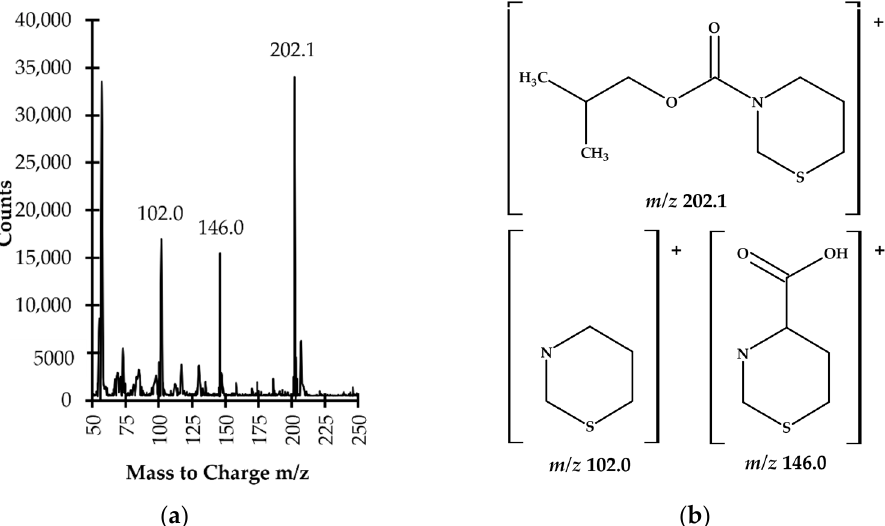
Figure 6. ( a ) Electron ionization (EI) mass spectrum of 1,3-thiazinane-4-carboxylic acid (TCA) isobutyl derivative (TCA-IBCF) obtained by analyzing a standard solution of TCA (60 µmol L − 1 ) prepared according to the procedure described in Section 3.5; ( b ) Proposed fragment ion structures in the EI mass spectrum of TCA-IBCF derivative.